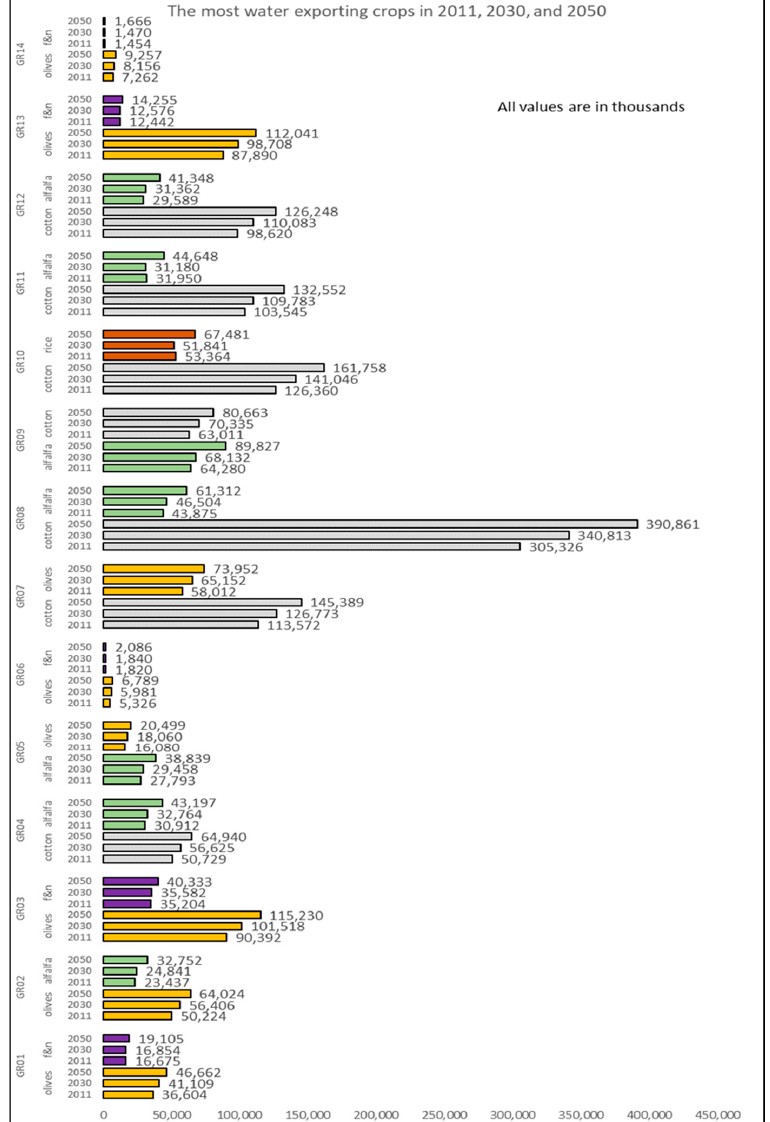
Figure 4. The two crop types with the highest virtual crop water exported per RBD in Greece